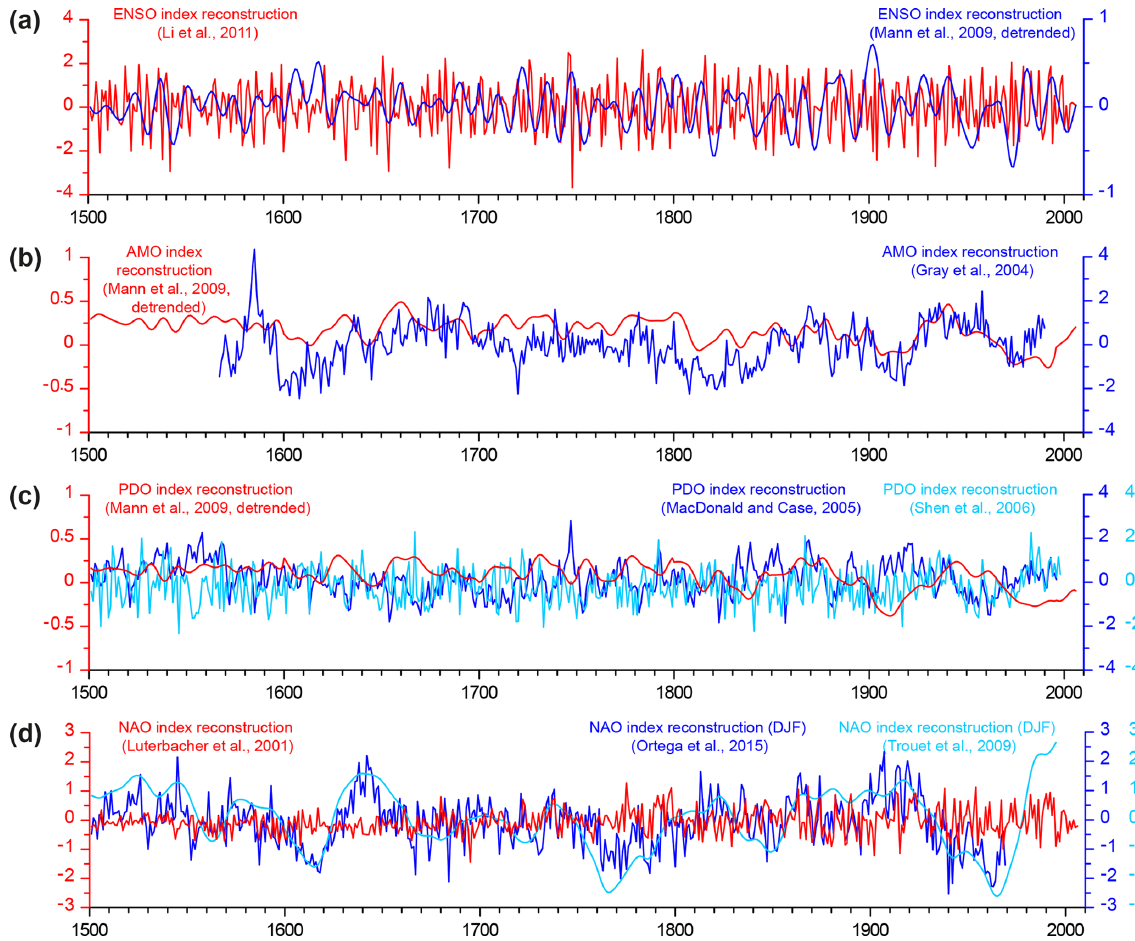
Figure 3. Reconstructed annual series of internal climate variability modes: (a) El Niño–Southern Oscillation (ENSO); (b) Atlantic Multi- decadal Oscillation (AMO); (c) Pacific Decadal Oscillation (PDO); (d) North Atlantic Oscillation